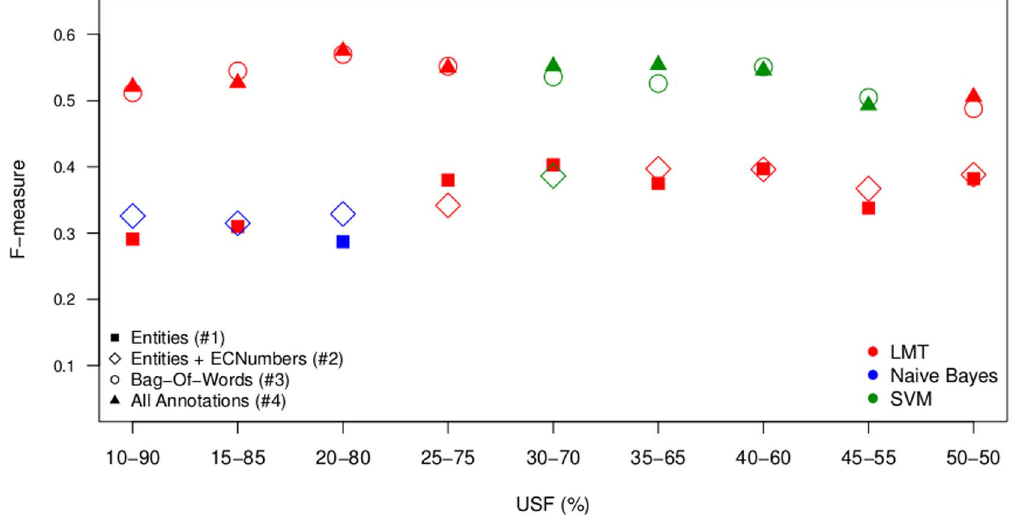
Fig. 3. mycoSORT F-measure scores. Results of the Best Classifiers for Each Classification Model.